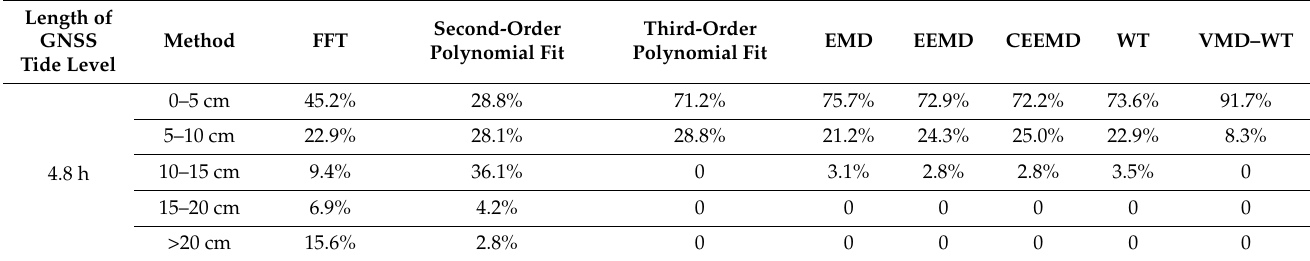
Table 4. Extraction error distribution of the eight filtering methods for 4.8